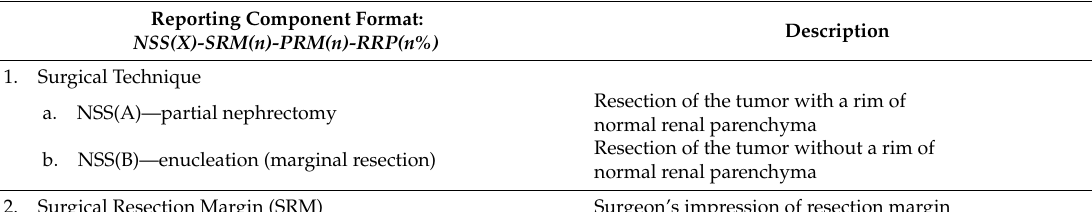
Table 2. International Society of Pediatric Oncology (SIOP) standardized reporting system for nephron sparing surgery